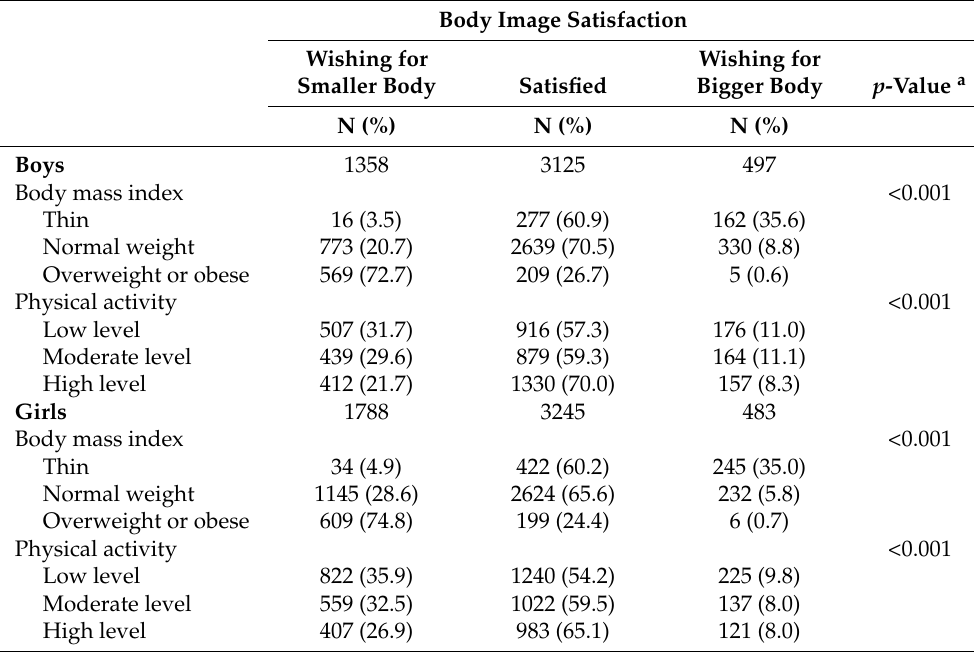
Table 2. Body image satisfaction by body mass index and physical activity